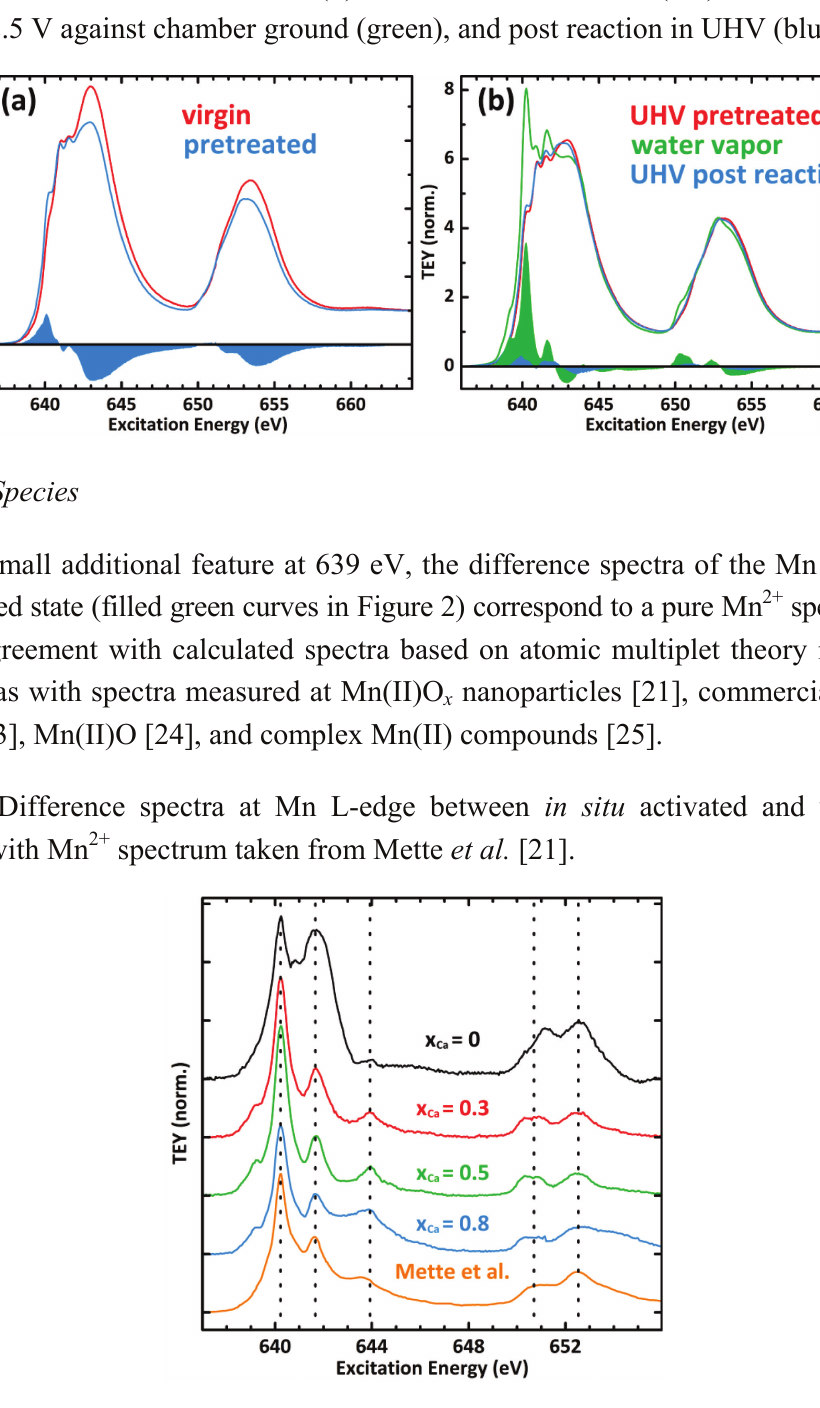
= 0.8). ( a ) Comparison to Ca O at 2